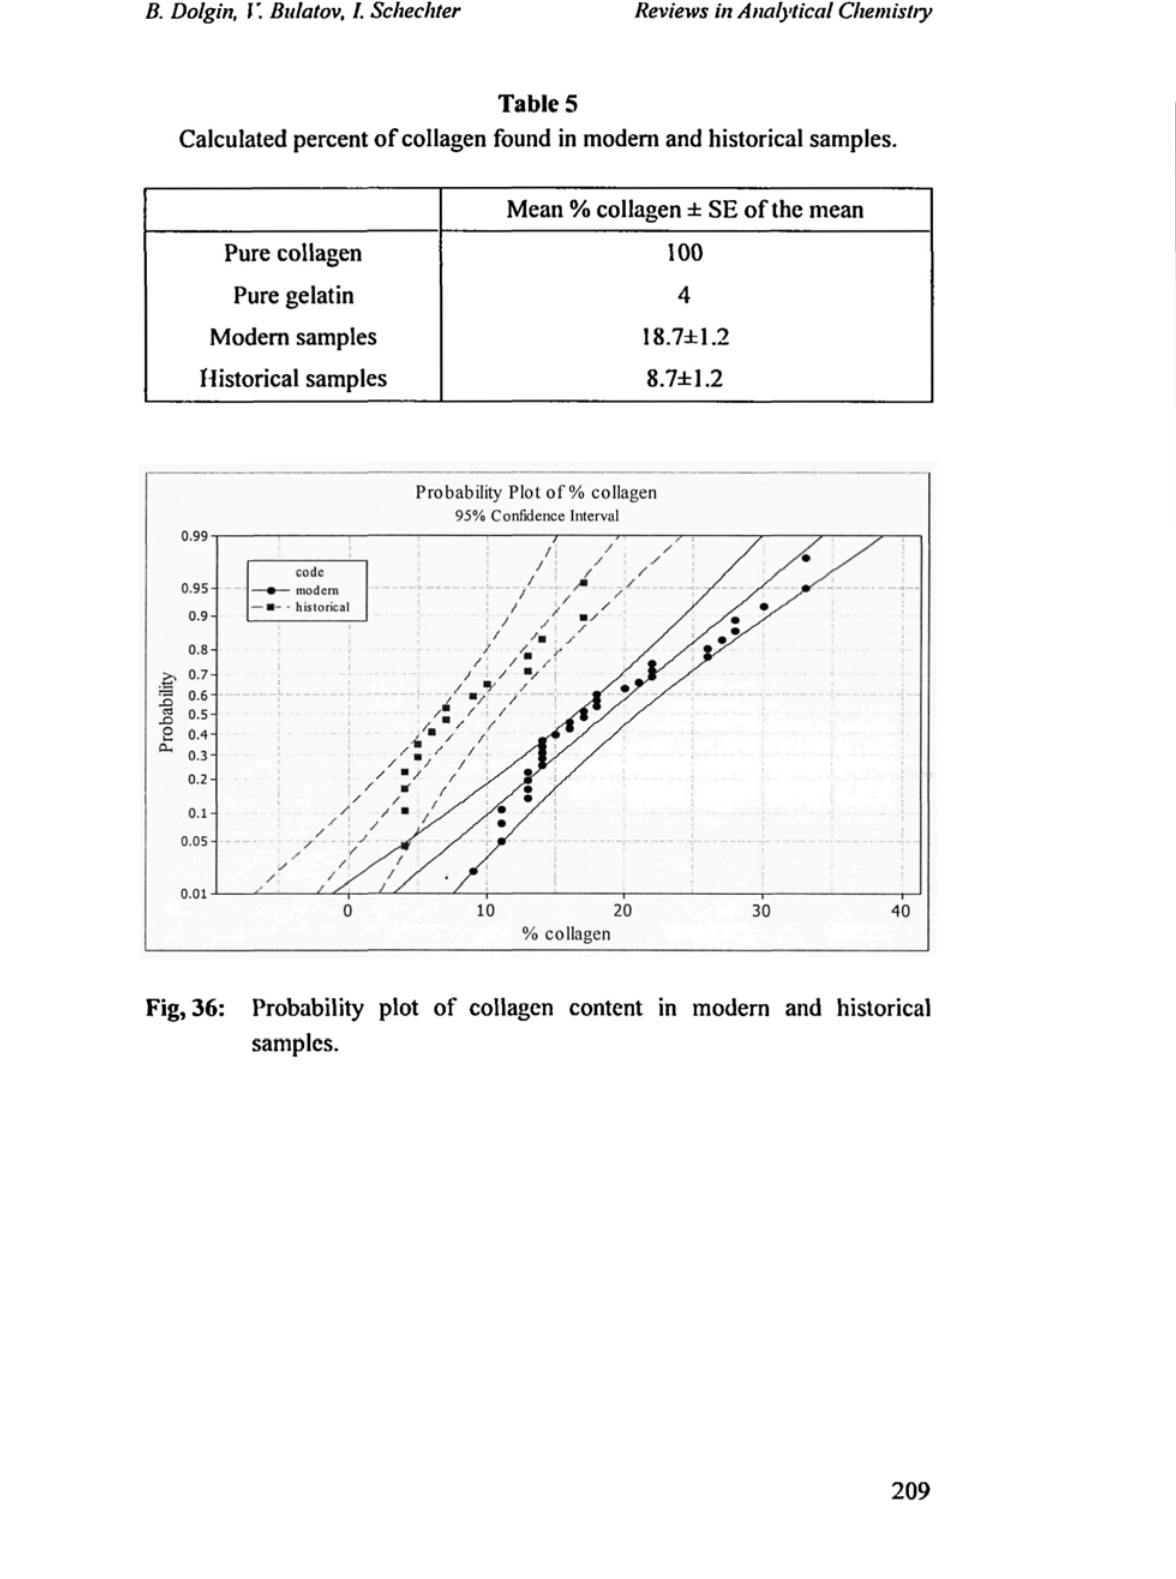
Calculated percent of collagen found in modern and historical samples.